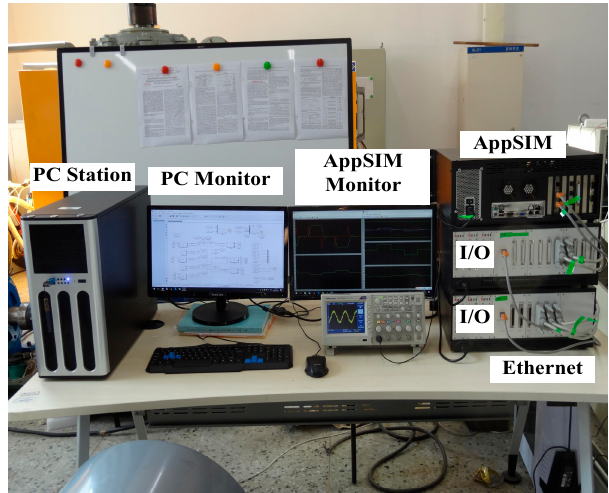
Figure 15. Configuration of the AppSIM real time simulator.